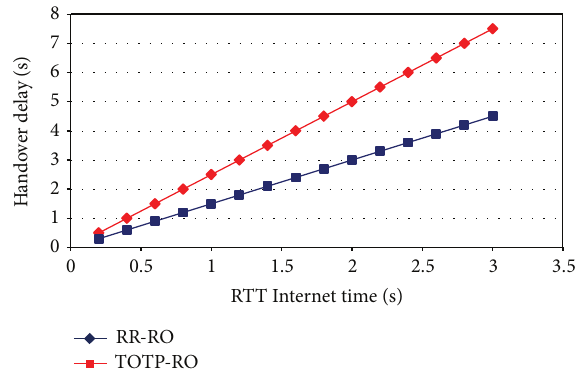
Figure 15: Handover delay comparison as a function of Internet time.